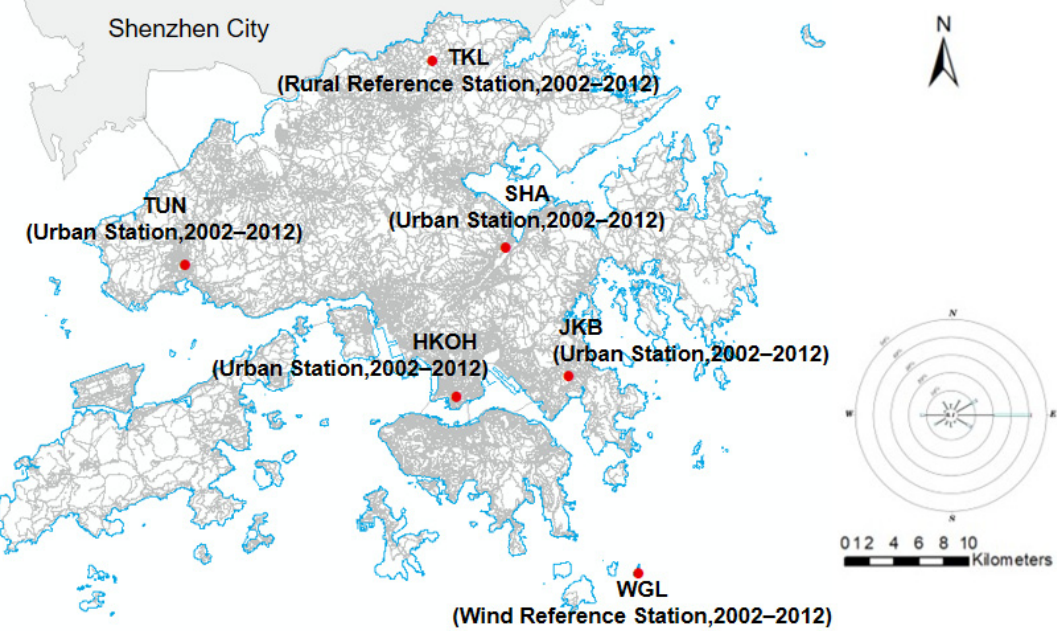
Figure 1. Location and data period of study weather conditions.